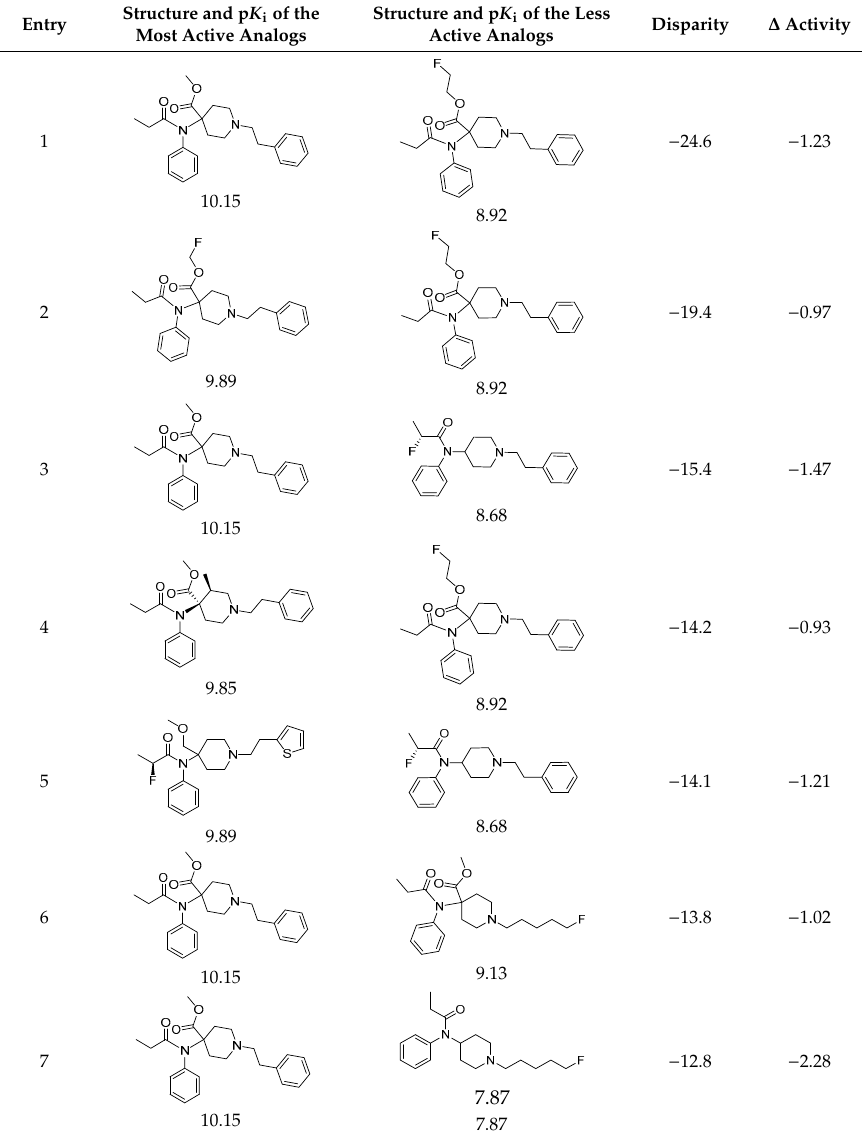
Table 2. Activity cliffs resulted from the AM approach.